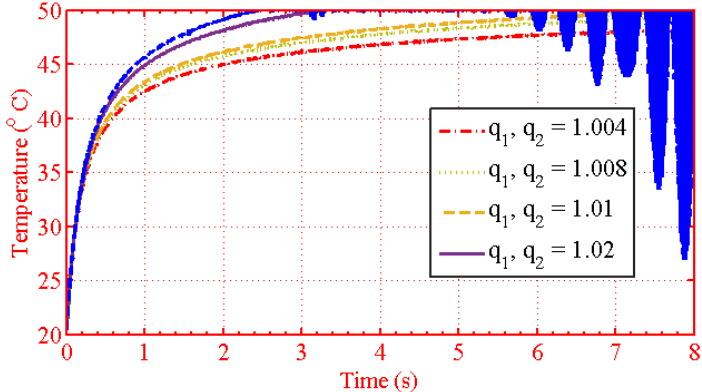
Figure 11. The output temperature in cold fluid as q 1 , q 2 >